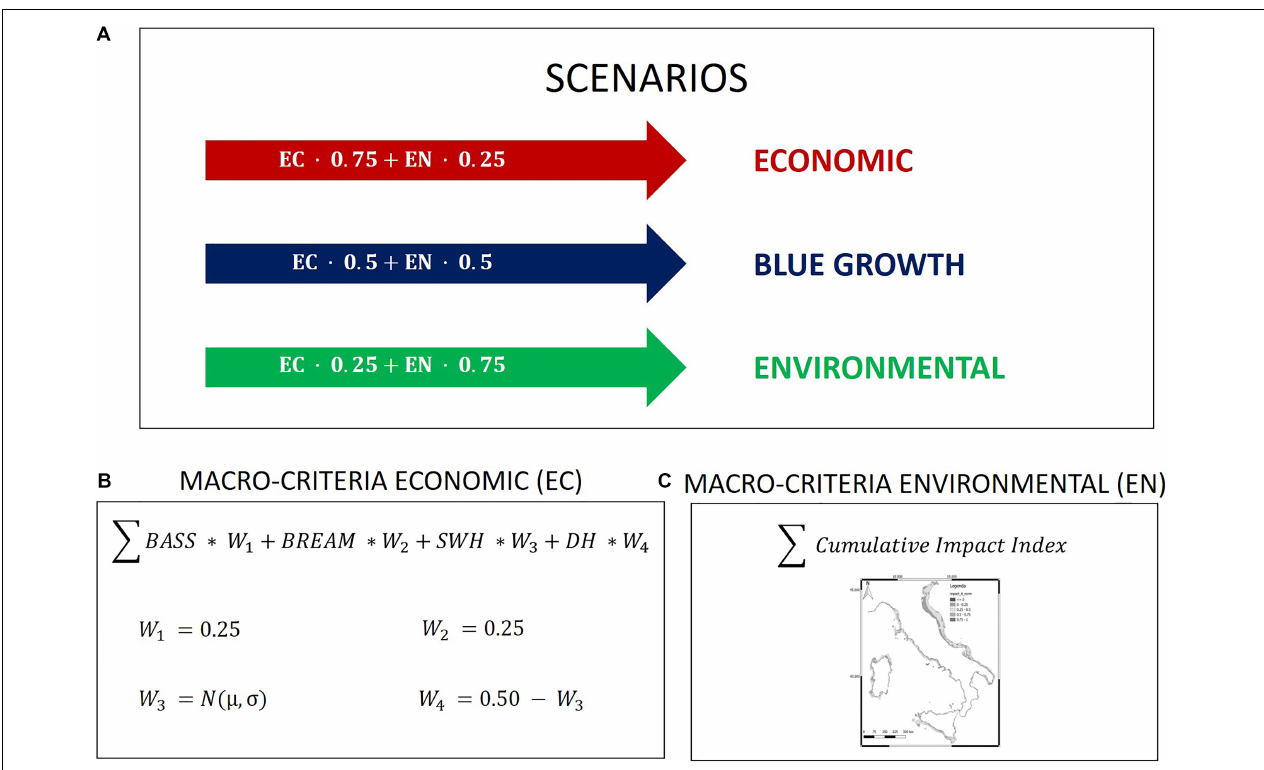
FIGURE 2 | Framework adopted for the scenario analyses. (A) Scenarios, weights assigned to the economic (W 1 ) and environmental (W 2 ) macro-criteria combined to obtain the Economic, Blue Growth and Environmental scenarios. (B) Macro-criterion economic, bass, bream, Significant Wave Height (SWH), Distance to Harbors (DH), W 1 , W 2 , W 3 , and W 4 the weights assigned to each ILC. (C) Macro-criterion environmental, map of cumulative impact